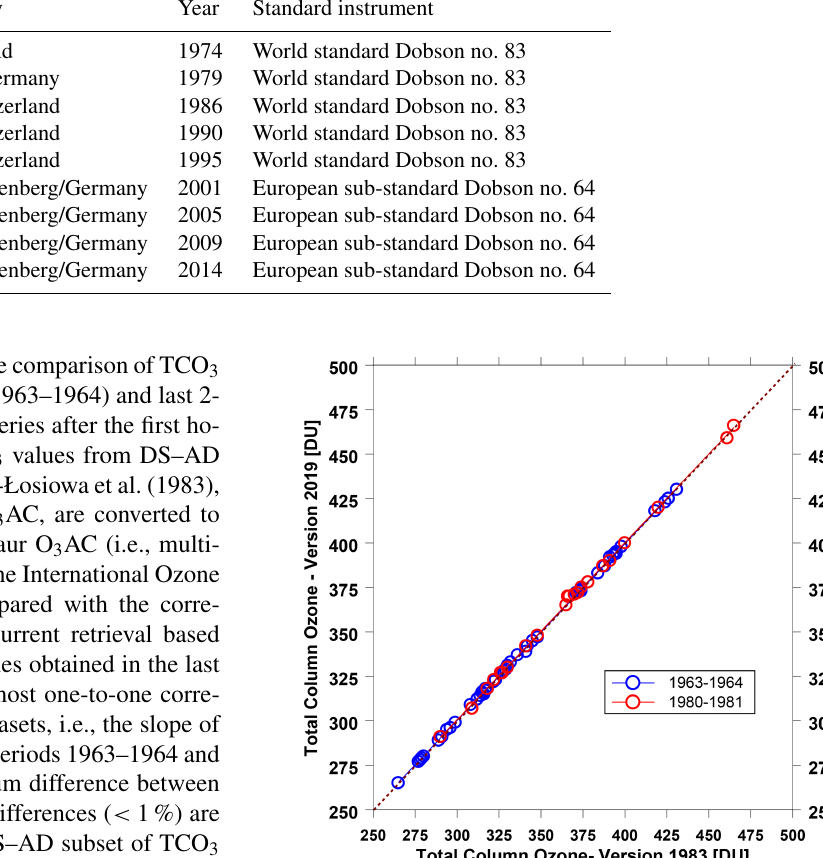
Table 1. The intercomparison campaigns with the Dobson instrument from Belsk. Site/country